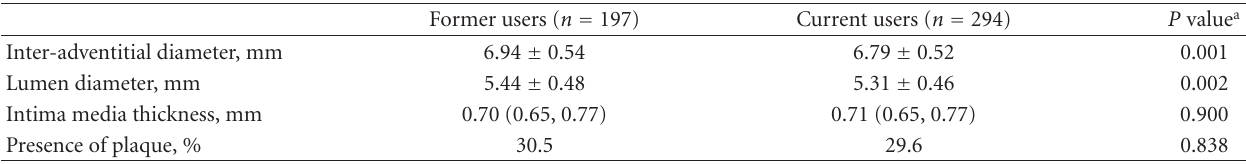
Table 2: Subclinical measures of cardiovascular disease by hormone therapy use.